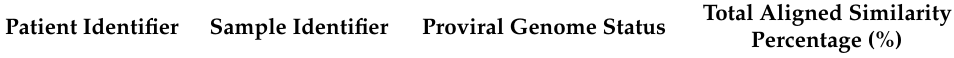
Table 3. Total aligned similarity between intact and defective HIV proviral genomes sequenced with Illumina ® MiSeq™ and